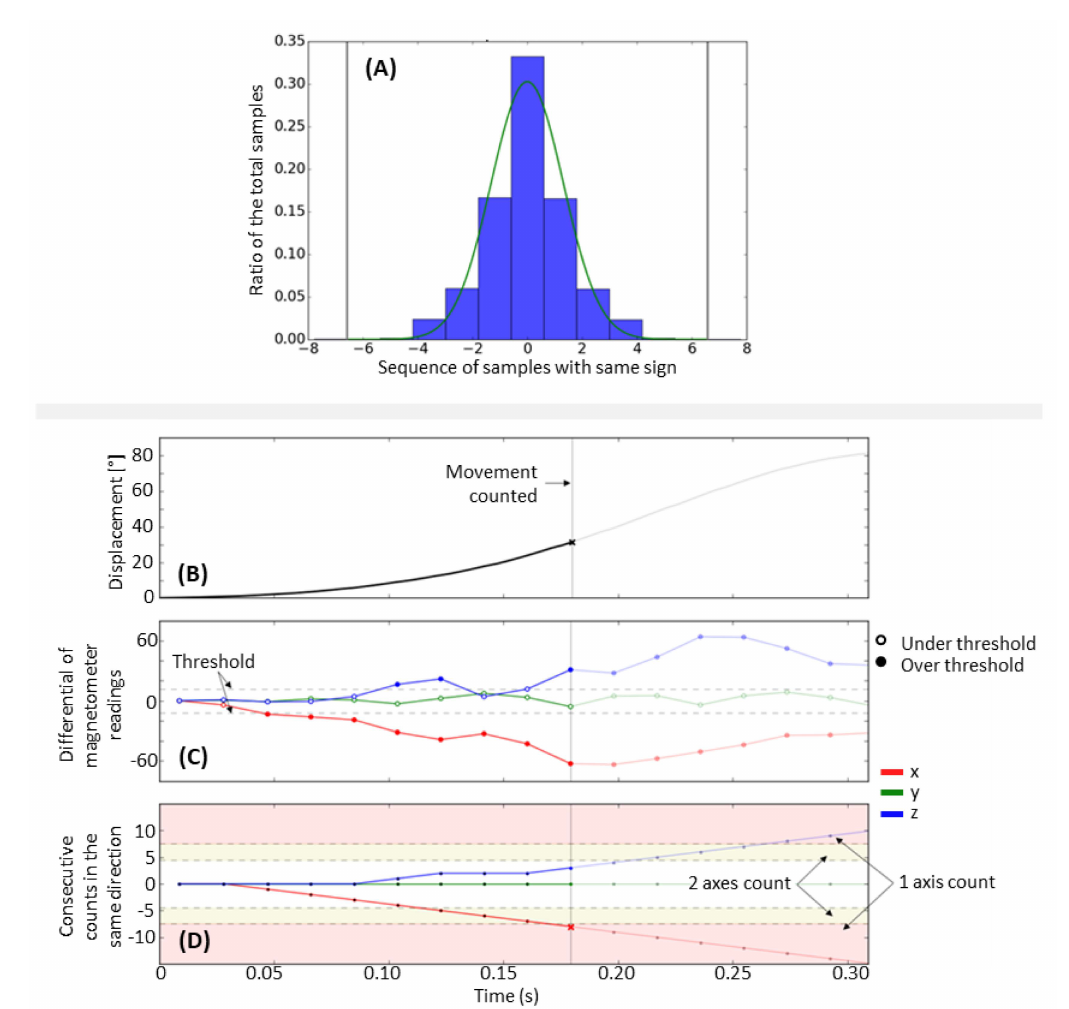
Figure 2. Overview of the Hand Activity estimated by Nonlinear Detection (HAND) count algorithm ( A ): Distribution of consecutive changes in the differential reading for all axes combined when the magnetic-sensing wrist-band rested on a table away from the ring magnet. 0 means that two consecutive differential readings had different signals (e.g., one positive, one negative), 1 means that there was 1 consecutive differential reading with the same signal, 2 means that there were two consecutive differentials with the same signal, etc. The grey vertical line shows three standard deviations from the mean. ( B – D ) Show an example of the HAND algorithm applied to data acquired during a wrist extension with the hand open ( B ), displacement in degrees of the wrist during an extension movement; ( C ) differential reading for each of the axes (x, y, z); each circle is one data point; dashed lines are the threshold of minimum (positive or negative) change to be counted; empty circles are not counted (within thresholds); filled circles are counted; ( D ) current count for each of the axes; yellow shaded area is the threshold for two axes together—when two axes are in the yellow area, it is counted; red shaded area is the threshold for one axis to be counted (in this example, the x -axis reached the threshold and the movement was detected). For this figure, LPcutoff = 16 Hz and threshold = 16 differential readings, which results in the standard deviation of 1.2 for the distribution of sample direction count. SDs (2 axes) and + SD (1 axis) were set to 4 and 3,